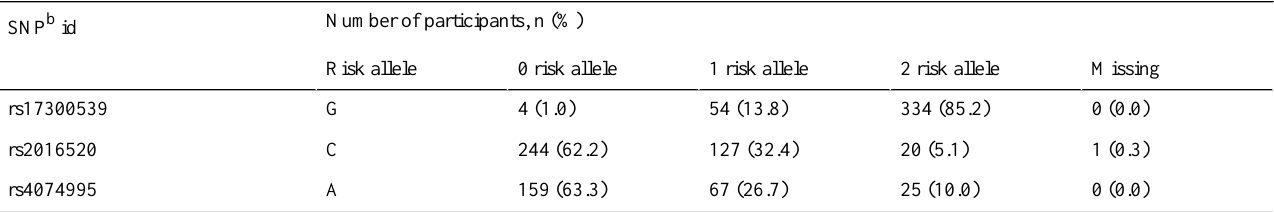
Table 3. Risk allele distribution of highlighted single-nucleotide polymorphisms from weight loss models. a